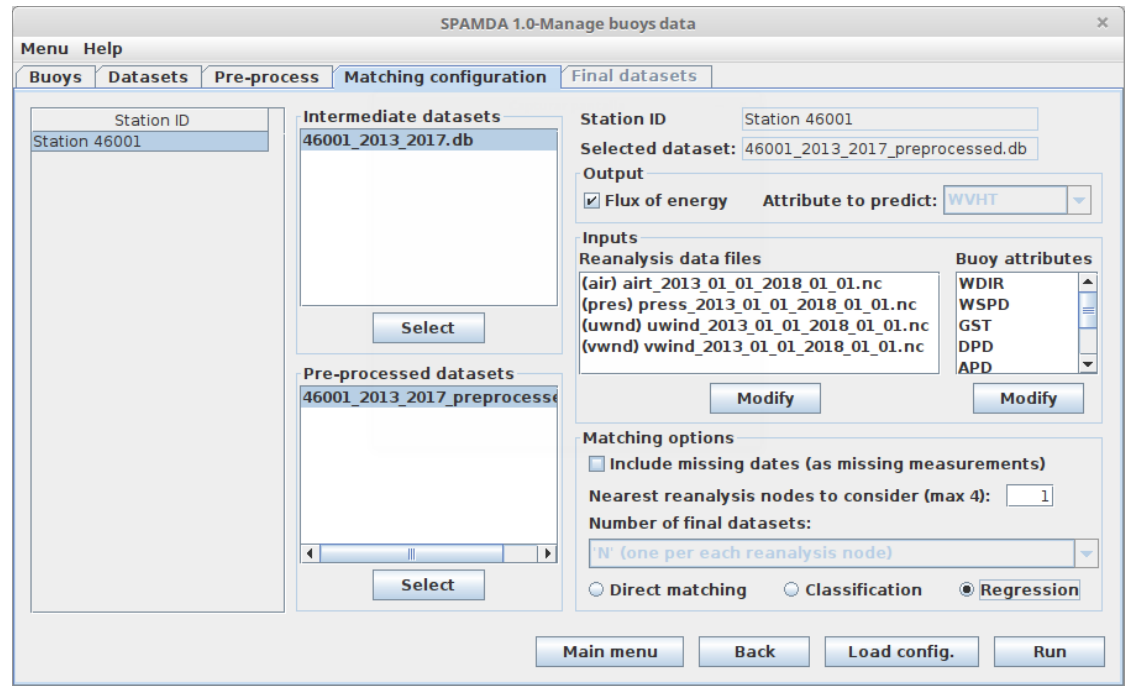
Figure 22. Matching configuration tab: parameters for the data integration of the intermediate dataset and the reanalysis files (energy flux prediction).